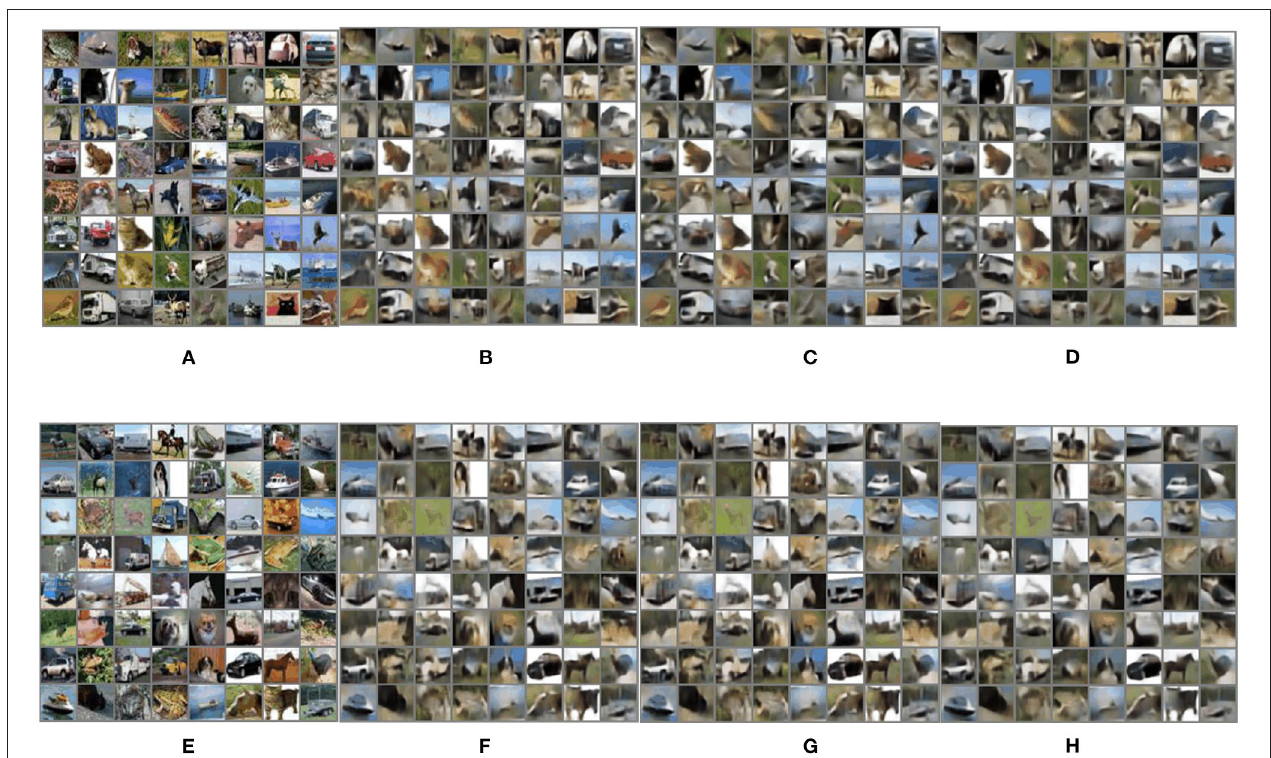
FIGURE 4 | Generative images on CIFAR-10 dataset using FrScatNet embeddings. (A) Original training images; (B) generative training images using FrScatNets with ( α 1 , α 2 ) = (0.4, 1); (C) generative training images using FrScatNets with ( α 1 , α 2 ) = (1, 1); (D) fused training image using FrScatNets with ( α 1 , α 2 ) = (0.4, 1 and ( α 1 , α 2 ) = (1, 1); (E) original testing images; (F) generative testing images using FrScatNets with ( α 1 , α 2 ) = (0.4, 1); (G) generative testing images using FrScatNets with ( α 1 , α 2 ) = (1, 1); (H) fused testing image using FrScatNets with ( α 1 , α 2 ) = (0.4, 1) and ( α 1 , α 2 ) = (1,